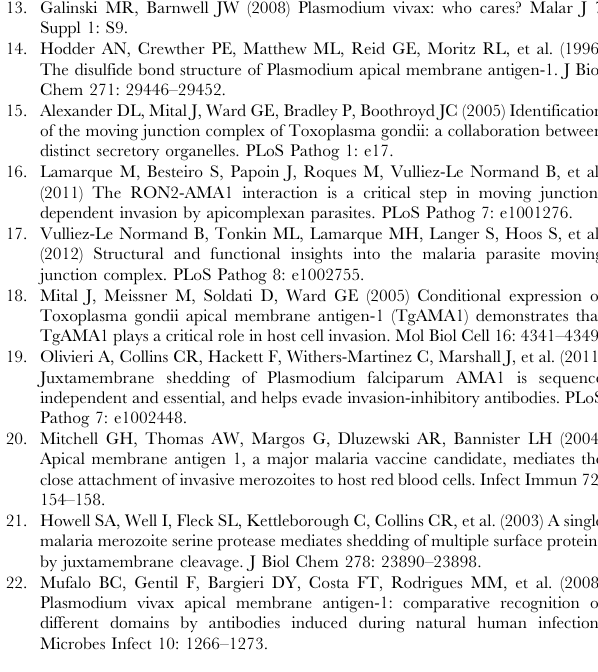
Figure S6 Network analysis of Pv AMA1 haplotypes with a frequency . 1. Haplotypes composed of 23 common amino acid polymorphisms with a frequency . 1 were analysed using the Median Joining algorithm implemented in Phylogenetic Network version 4.6.1.1 software. Coloured nodes represent the haplotypes and lines indicate connections between them. The size of each node indicates haplotype frequency. Table S1 Published Pvama1 sequences obtained from GenBank. (DOC) Table S2 Summary of Pv AMA1 polymorphisms. All 40- mer haplotypes for the 372 global sequences are summarised here. The polymorphic amino acid residue, and corresponding nucleotide polymorphism(s) are listed, as are the reference Sal-1 sequence and variant codons for each polymorphic site. Sites identical to the Sal-1 sequence are indicated by a dot. The number of sequences identical to Sal-1 at each polymorphic site are also listed. The 23 common polymorphisms are shown in